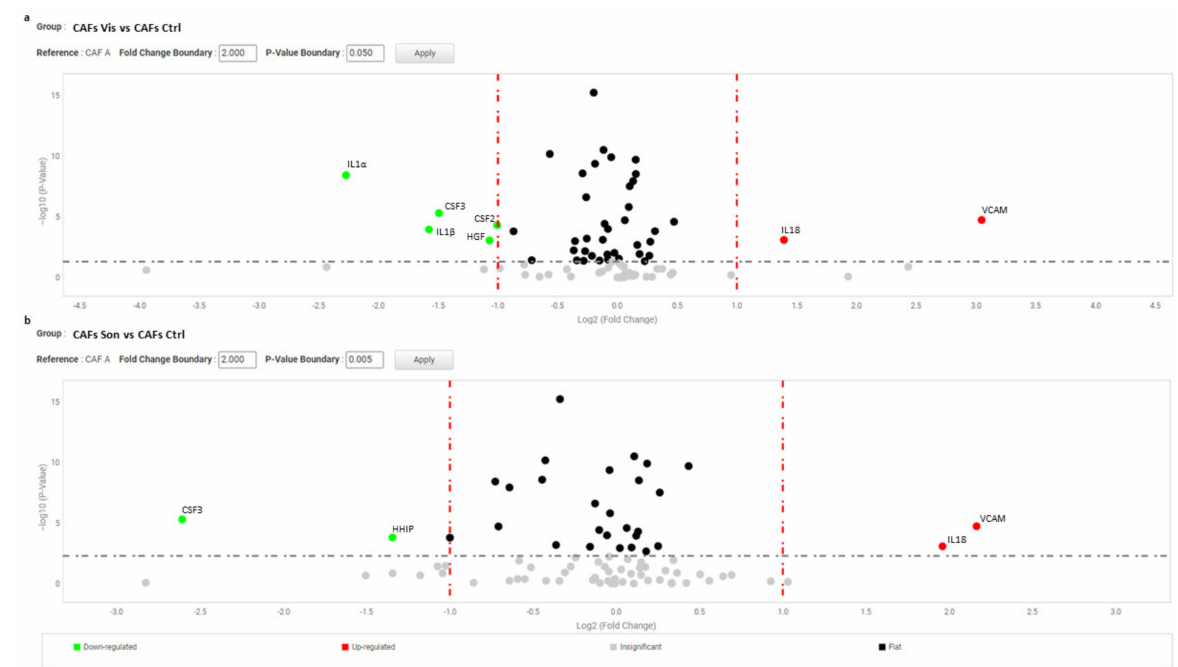
Figure 5. Volcano plot represents gene expression analysis comparing CAFs treated with vismodegib ( a ) and sonidegib ( b ) for 72 h (n = 6) to CAFs untreated (n = 6). (b) Analysis was performed using three different housekeeping genes ( β -actin, GAPDH and 18S). One-way ANOVA statistical test with thresholds >2.0 fold-change and p < 0.05 defined significant increase are reported in red; significant decrease <0.5 fold-change and p < 0.05 reported in green; any fold-difference with p ≥ 0.5, e.g., insignificant are reported in grey; ≤ 2.0 or ≥ 0.5 difference e.g., flat reported in black.